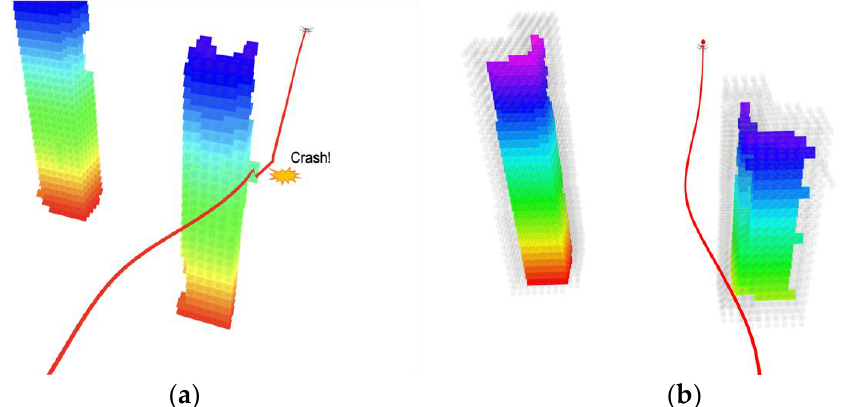
Figure 5. Snapshots and inflated maps when a MAV flies through obstacles in the gazebo. ( a ) trajectory planning on the occupancy grid map. ( b ) trajectory planning on the inflated map.